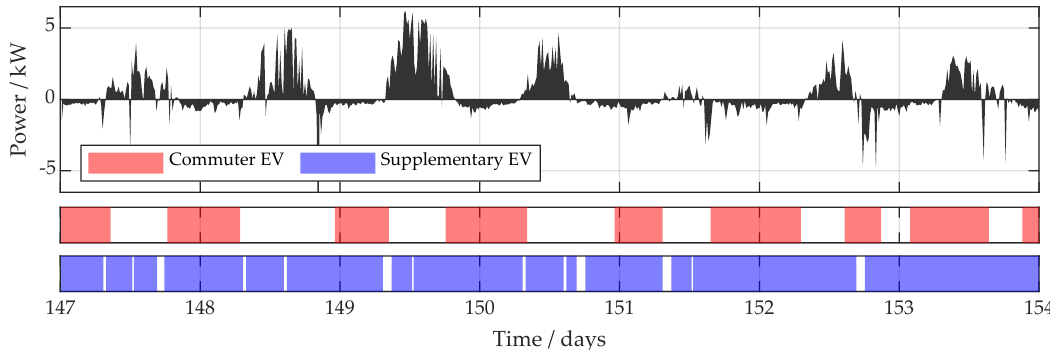
Figure 4. Residual power of exemplary week (Monday to Sunday) where photovoltaic (PV) excess power is characterized by positive values and the associated plug-in times (colored area) of the electric vehicles (commuter EV = red, supplementary EV =